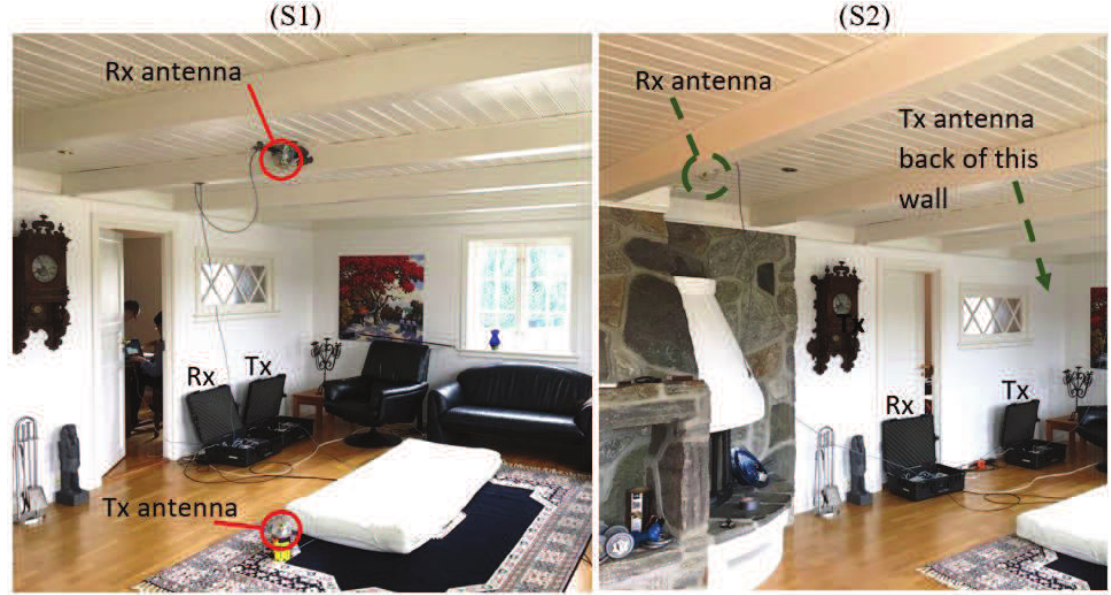
Figure 1. The in-home propagation area, where the measurement campaign was conducted under both LOS (S1, left ) and OLOS (S2, right )